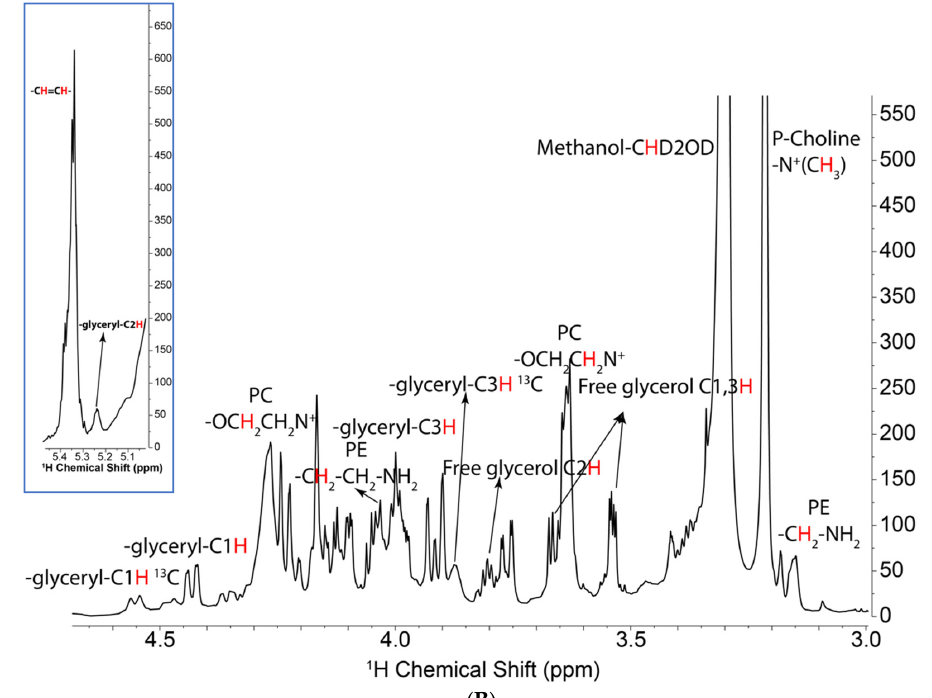
ppm. ( B ) Lower: downfield region showing glycerol and headgroup region; inset shows the